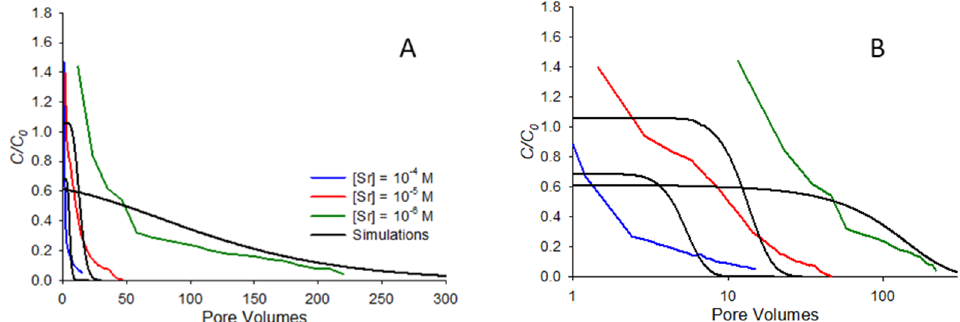
Figure 6. Experimental and simulated remobilization elution curves at pH 9, ionic strength 0.01 M NaNO 3 , showing the release of strontium at pH 9 following resaturation after the evaporation of porewater. Simulations correspond to the parameters determined from the saturated breakthrough curve fits in Figure 5.